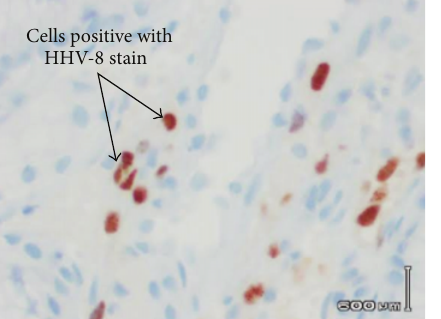
Figure 4: Gastric lesion biopsy showing cells positive with HHV-8 stain